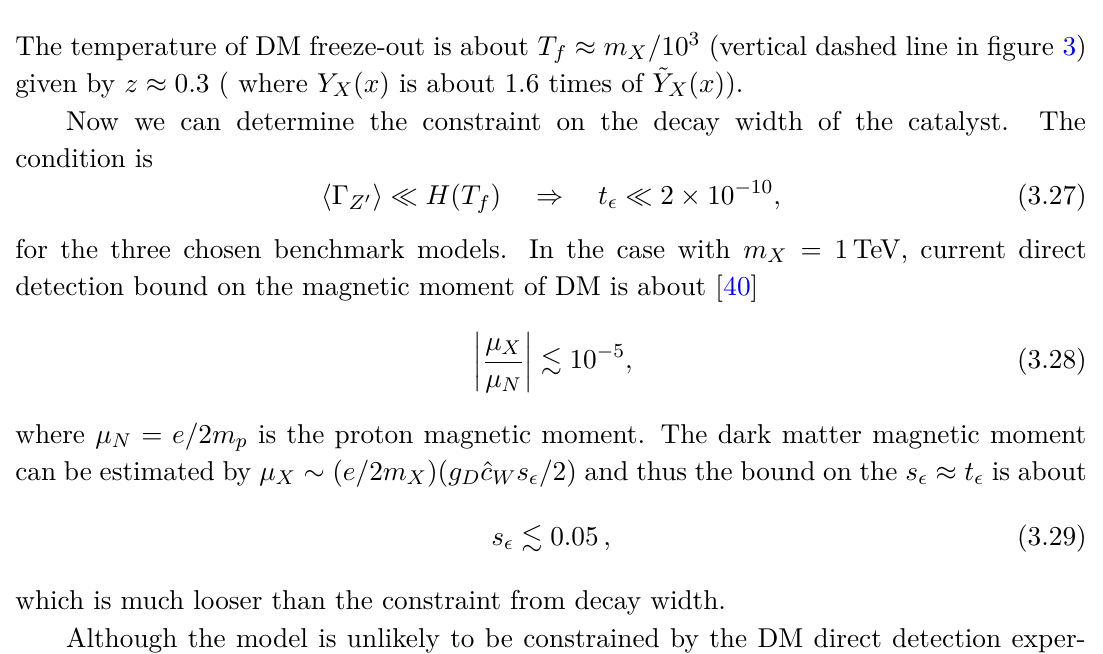
Figure 3 . The evolutions of Y Z 0 ( x ) (dashed lines) and Y X ( x ) (solid lines). In the left panel, t (cid:15) = 10 − 11 , ξ X = ξ Z 0 = 10 − 5 is chosen for the three benchmark models with ( m X , r 1 / 2 (1 TeV , 1 . 32 , 1 . 015) (magenta lines), and (6 TeV , 1 . 25 , 2 . 55) (blue lines). The black dotted lines are the approximated results of Y X ( x ) given by eq. (3.23). In the right panel, m X = 1 TeV , r 1 / 2 1 . 3 , g D = 0 . 68 , t (cid:15) = 5 × 10 − 9 , ξ X = ξ Z 0 = 10 − 5 is chosen. The black dotted line is the approximate solution of Y X ( x ) given by eq.